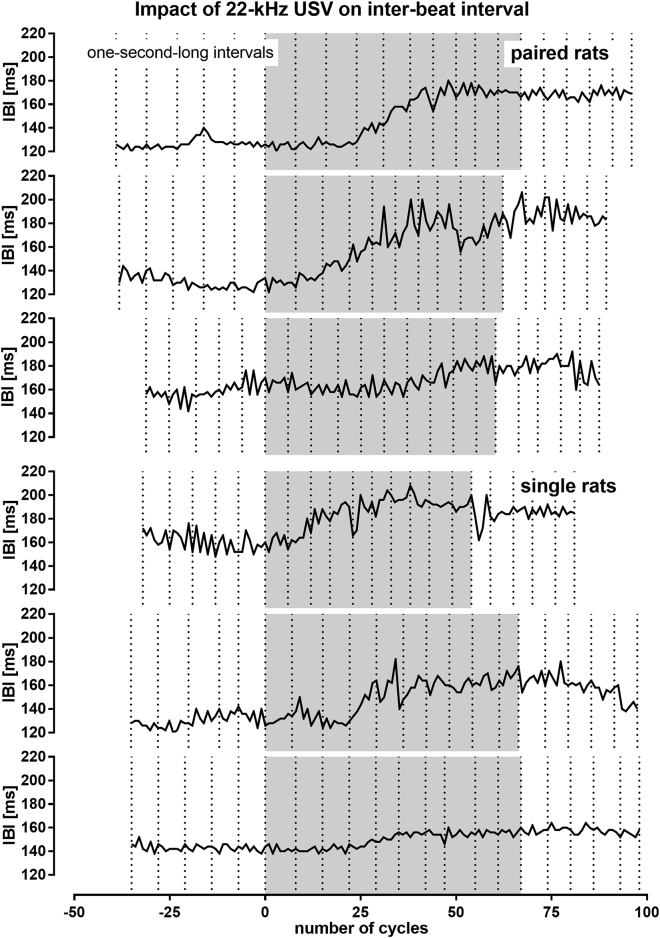
Impact of 22-kHz USV Playback on Inter-Beat Interval (IBI) of Paired (Top Three) and Single (Bottom Three) Randomly Selected Rats That Experienced 22-kHz USV Playback as their First Playback (Comp. Figure 1)Gray sections correspond to the 10-s-long ultrasonic presentation. Dotted vertical lines indicate 1-s-long intervals. In general, 22-kHz USV presentation evoked increase in IBI (i.e. HR decrease); the increase process lasted approx. 2–5 s in each rat.